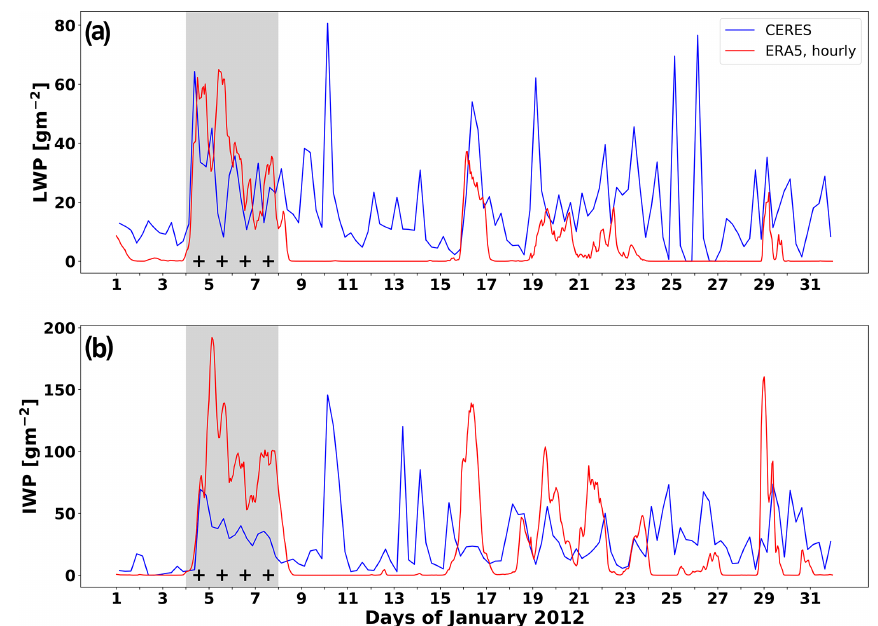
Figure 9. As in Fig. 5 but over the Pine Island and Thwaites Glacier region throughout January 2012.